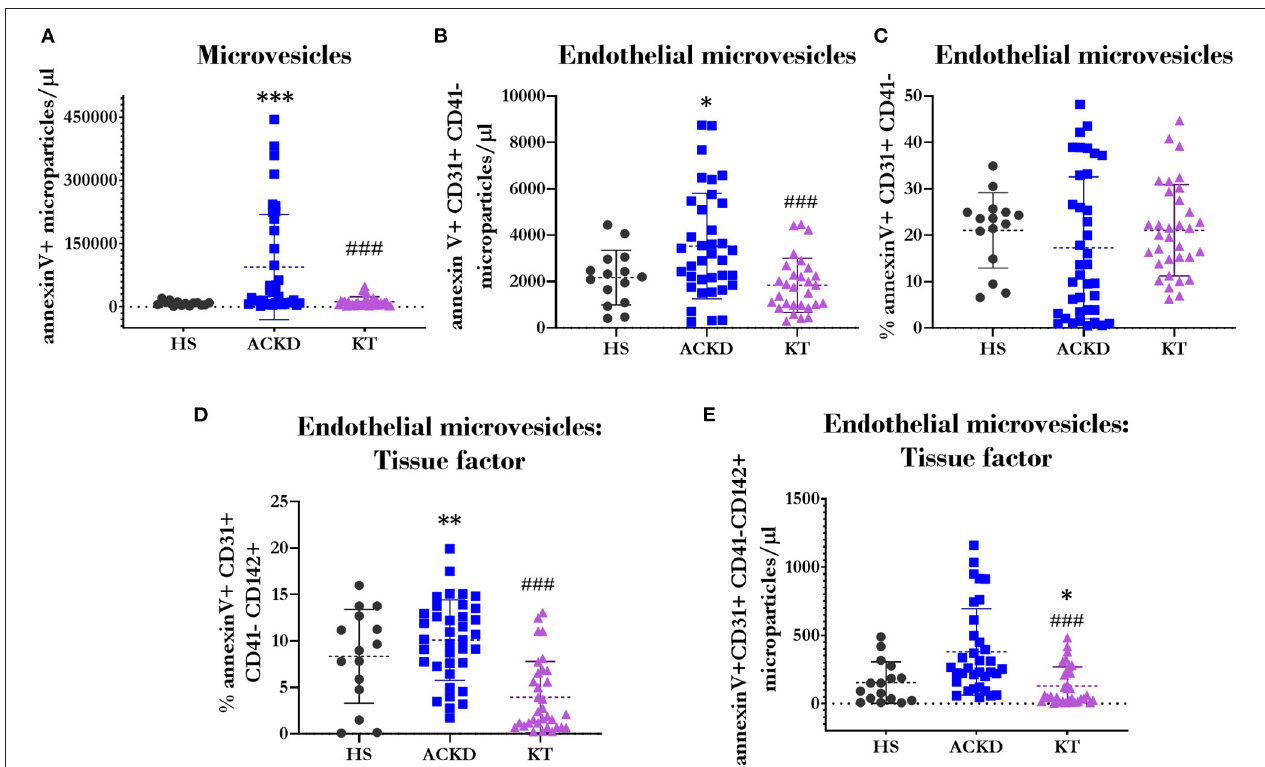
FIGURE 8 | Description of the microvesicles phenotype. Total number of microvesicles Φ (A) (annexin V + ); number Ω (B) and percentage Ω (C) of endothelial microvesicles (annexin V + CD31 + CD41–); and percentage Ψ (D) and number Φ (E) of endothelial microvesicles expressing tissue factor (CD142) in healthy subjects (HS), patients with advanced chronic kidney disease (ACKD), and patients with kidney transplantation (KT). * p ≤ 0.05, ** p ≤ 0.01, and *** p ≤ 0.001 vs. HS; ### p ≤ 0.001 vs. ACKD. Statistical analysis: Ψ ANOVA (Tukey test). Ω ANOVA (Games–Howell test). Φ Mann–Whitney U- test. ANOVA, analysis of variance.